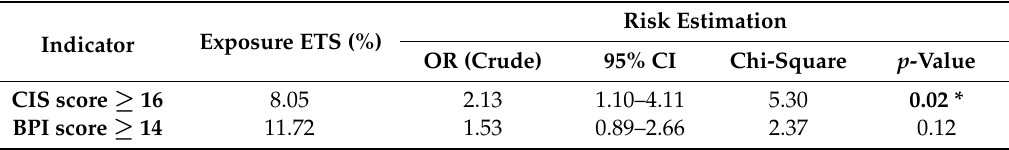
Table 4. Relations between emotional functions (CSI) and behavioral functions (BPI) and the exposure of children to mother’s smoking † ( n = 1373) (bivariate analysis).